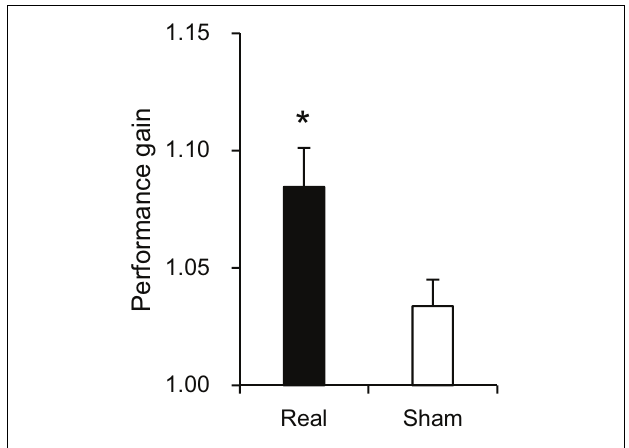
FIGURE 3 | Comparison of performance gain between the real and sham groups. * P < 0.05.